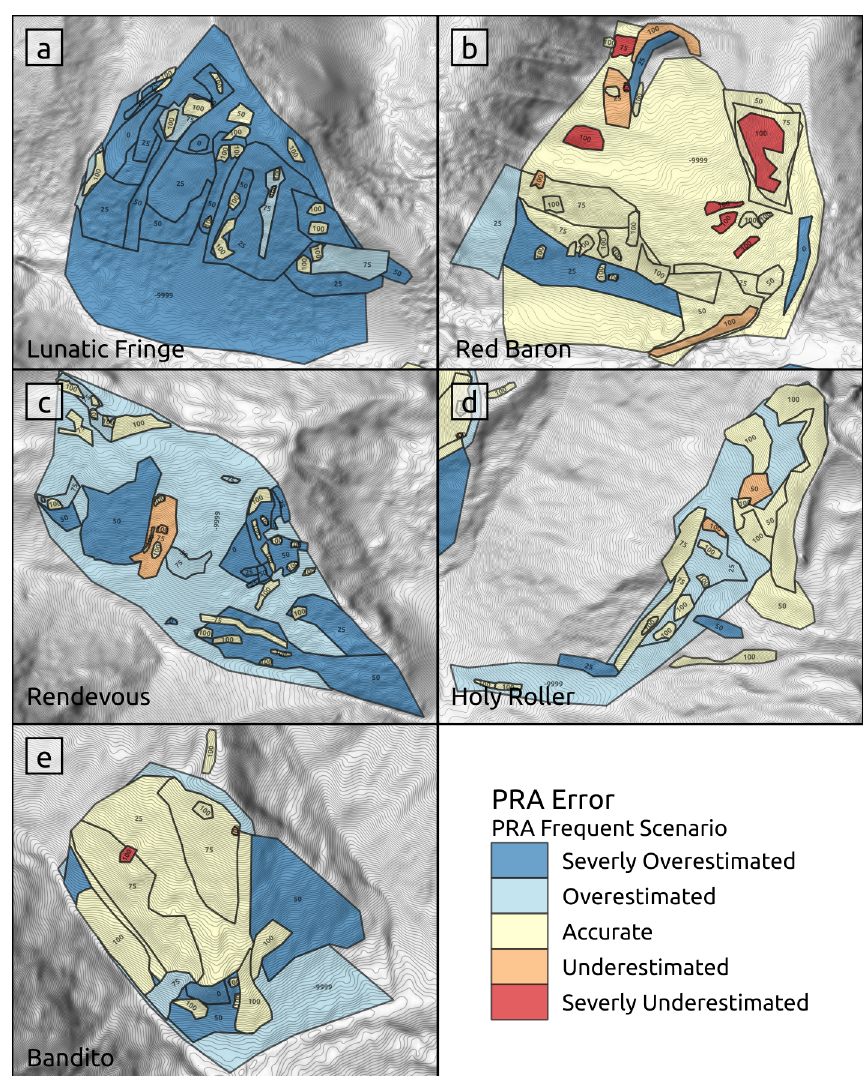
Figure 13. PRA model accuracy for each validation run, with the downslope direction at the bottom of each panel. Validation polygons are labeled by the guides’ estimated release area proportion and color-coded based on their PRA error. For overlapping validation polygons we retain the highest release area proportion value and clip that area from the surrounding lower-proportion